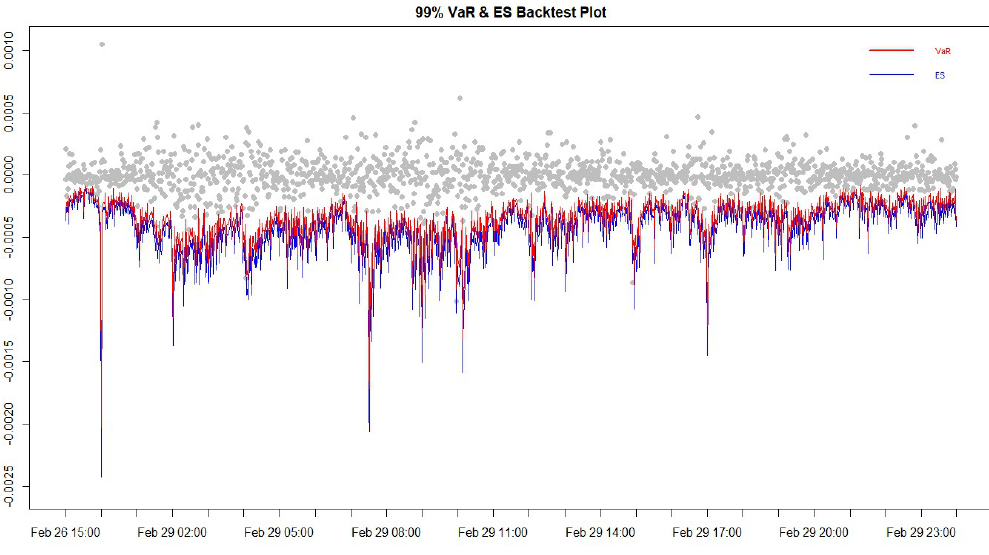
Figure 10. Backtest graph for MC-GARCH_GED.